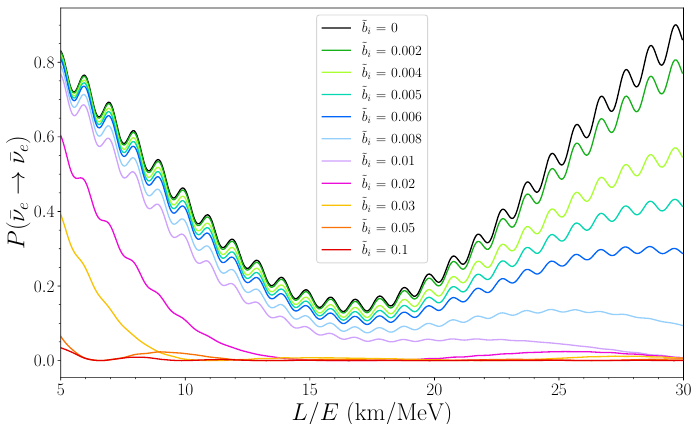
Figure 7. Plots of the anti-electron neutrino survival probability as a function of L/E for the 3-flavour top-hat density of states as defined in section 2.5 with ˜ b 1 = ˜ b 2 = ˜ b 3 = ˜ b , for various values of ˜ b . The case ˜ b i = 0 corresponds to the standard scenario in which the density of states is comprised of 3 δ